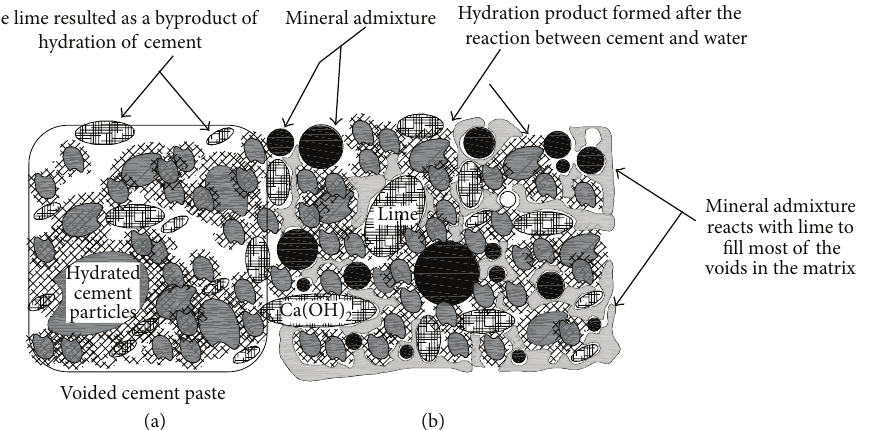
Figure 1: (a) Formation of lime as a byproduct of hydration of Portland cement resulting into a porous paste. (b) Pozzolanic reaction between lime and mineral admixture to fill the interstitial